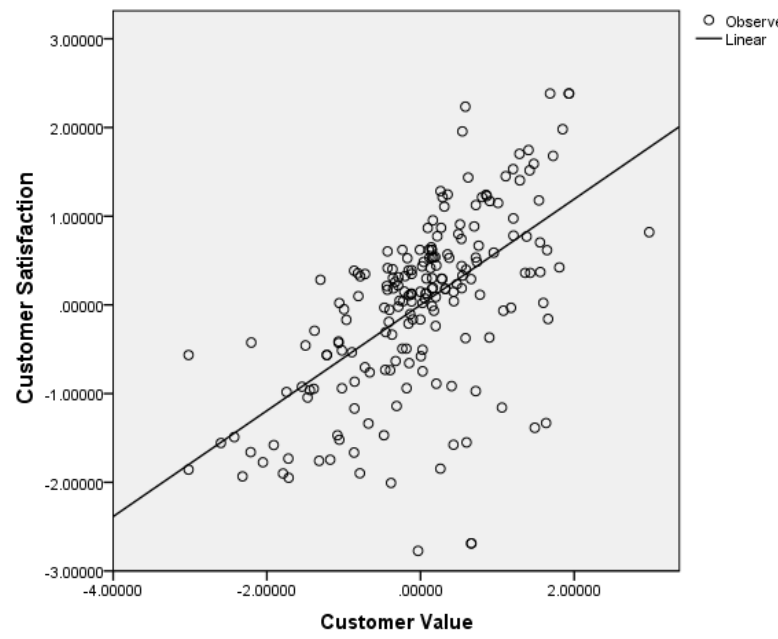
Figure 2 Scatter plot between Customer Value and Customer